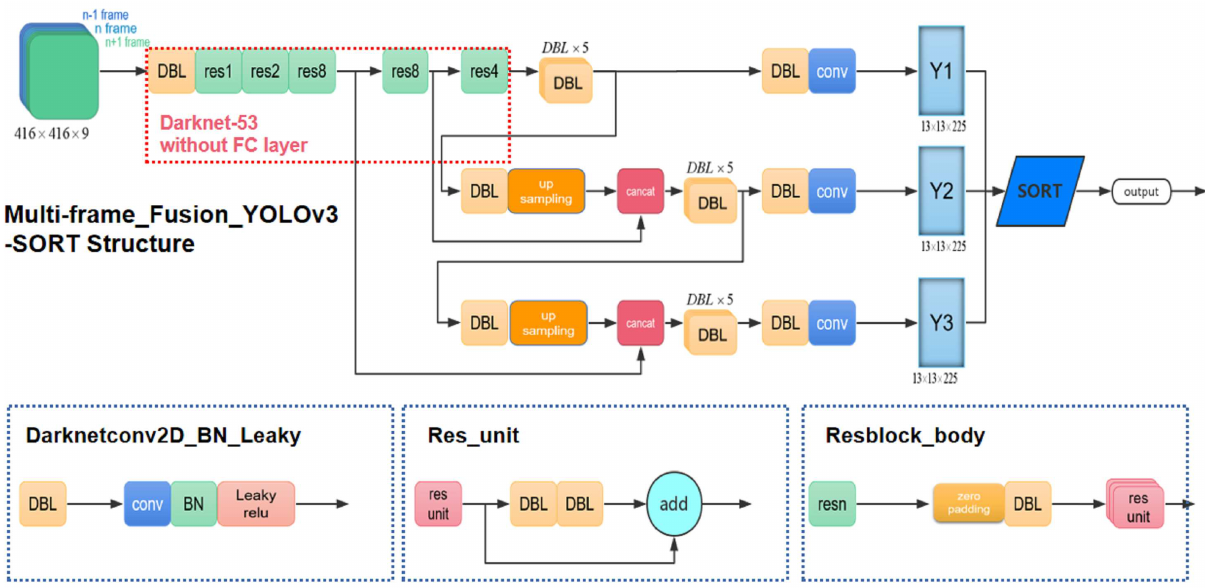
Figure 1. Overview of the proposed method based on YOLO v3 and